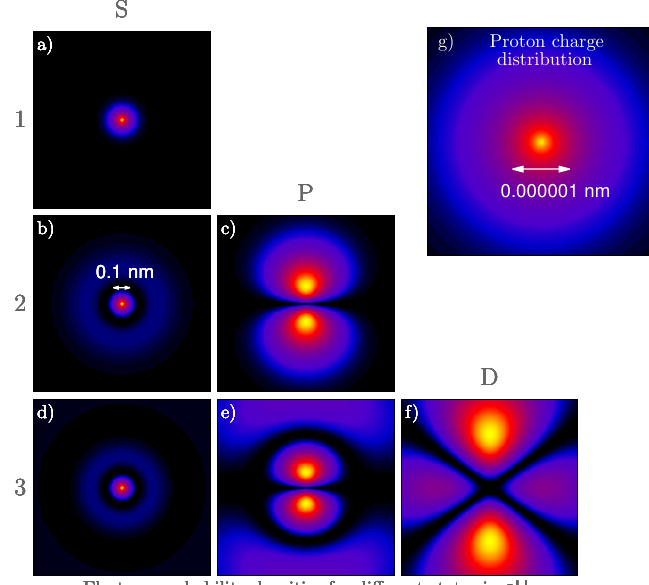
Figure 2. a-f) Projections of the probability densities for the elec- tron in the Hydrogen atom to the xz-plane. The results are shown for electrons with principal quan- tum number n = 1 , 2 , 3 and or- bital quantum numbers l = S , P , D . g) The proton charge distribution at the center of the hydrogen